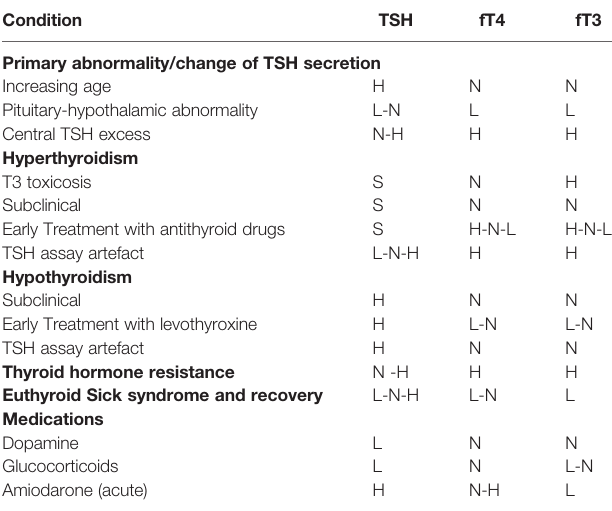
TABLE 2 | Some situations in which serum TSH alone can give a false or uncertain indication of thyroid status in elderly people compared to the normal reference interval in young persons.